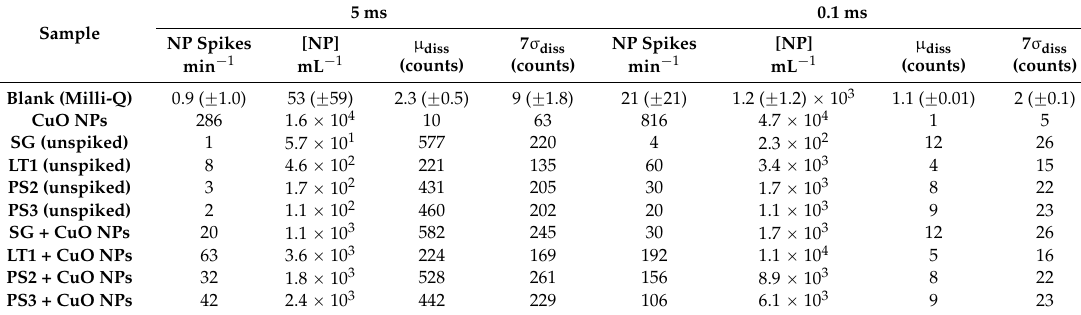
Table 2. Number of particle spikes, particle number concentration (mL ´ 1 ) at 5 ms and 0.1 ms dwell time for the CuO NP suspension, unspiked and spiked soil extracts. Additionally, the average data for the blank measurements (in Milli-Q) are provided (for 5 ms n blanks = 13 and for 0.1 ms n blanks = 8). 5 ms 0.1